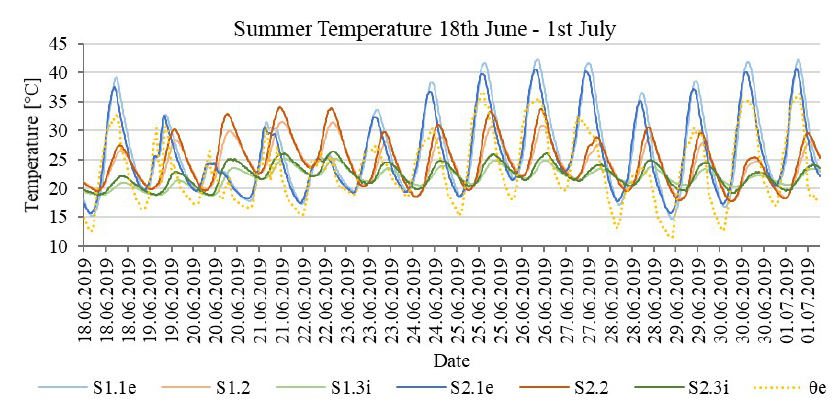
Figure 8. Comparison of the temperature in the summer period.